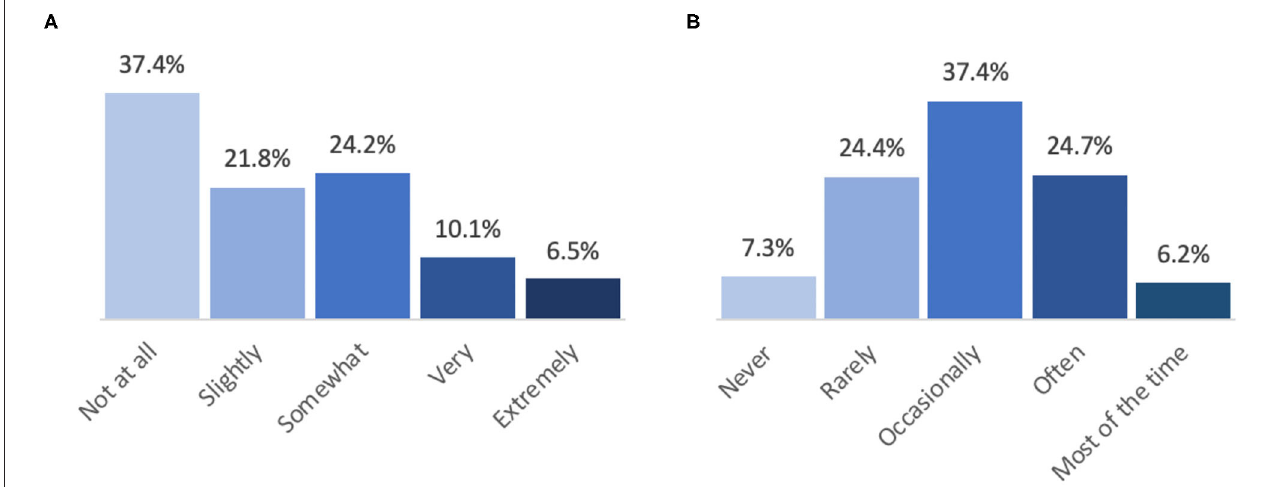
FIGURE 1 | Students’ self-reported mental health and frequency of reading or talking about the COVID-19 pandemic during the past 2 weeks. (A) During the past 2 weeks, how worried have you been about your mental/emotional health being influenced by the COVID-19 pandemic? (B) How much are you reading or talking about the COVID-19 pandemic?